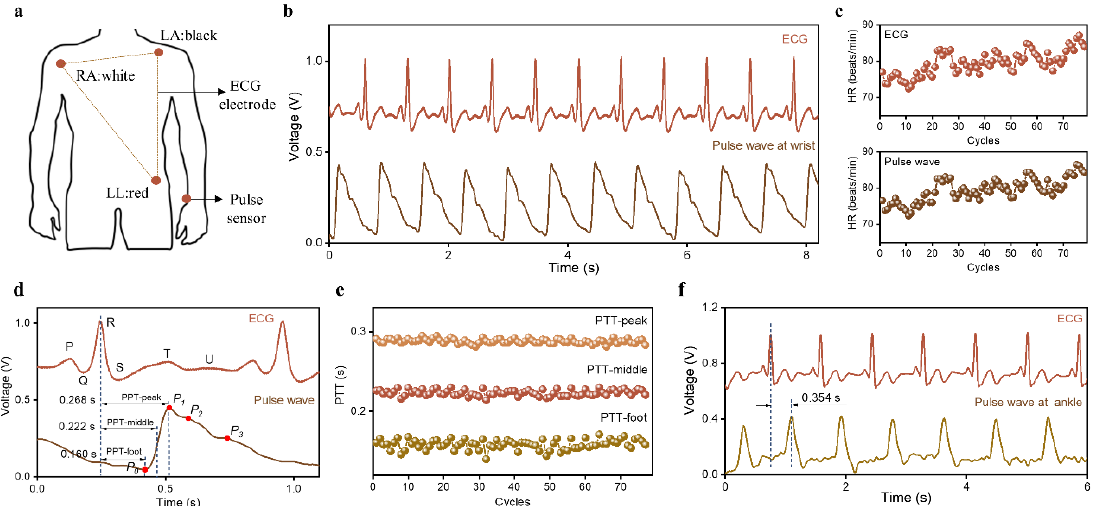
Figure 6. Measurement of PTT: ( a ) schematic diagram of ECG electrode position, ( b ) ECG signals and pulse waves of the same individual obtained by the ECG electrode and the HBPS, ( c ) HR obtained from ECG and pulse wave, ( d ) definition of PTT, ( e ) changing trend of PTT over 78 consecutive cycles, and ( f ) ECG and pulse wave measured at the ankle.